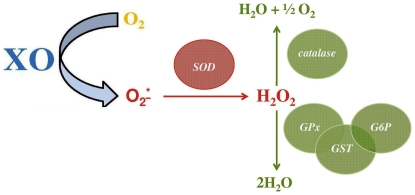
Simplified illustration of enzymatic pathways of superoxide radical dismutation.Superoxide radical, generated by xanthine oxidase activity is neutralized by superoxide dismutase, leading to hydrogen peroxide synthesis. Afterwards, two possible pathways of hydrogen peroxide neutralisation exists – either via catalase activity or via glutathione-related compounds i.e. mainly by glutathione peroxidase that cooperates with glutathione transferase and glucose-6-phosphate dehydrogenase. Glutathione, itself, is the most important “stabiliser” of intracellular oxidative balance. XO – xanthine oxidase, SOD – superoxide dismutase, GPx – glutathione peroxidase, GST – glutathione transferase, G6P – glucose-6-phosphate dehydrogenase, O2-* – superoxide radical, H2O2 – hydrogen peroxide.